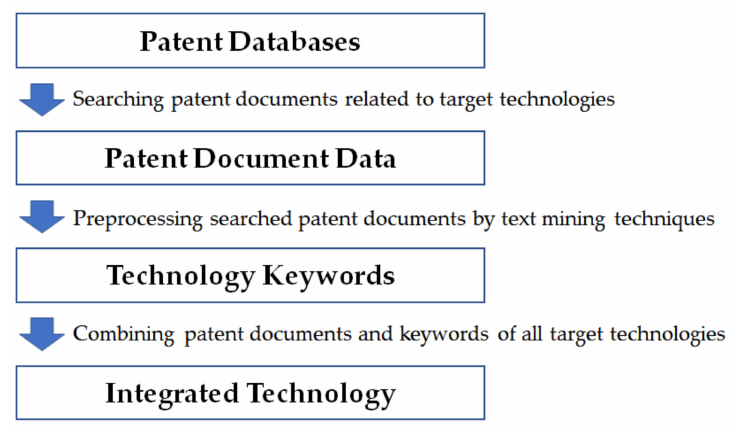
Figure 1. Technology integration using text